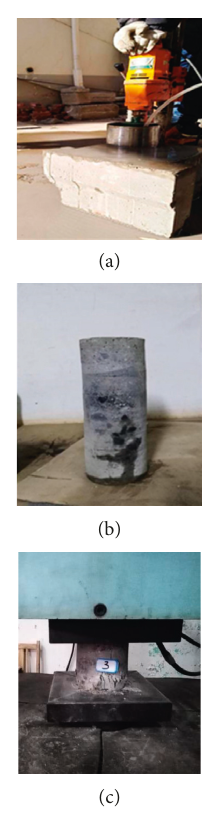
Figure 10: Compression failure of core sample. (a) Core